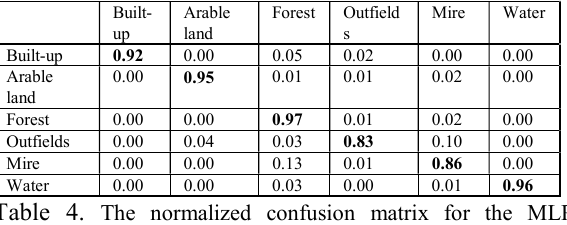
Table 4. The normalized confusion matrix for the MLP algorithm